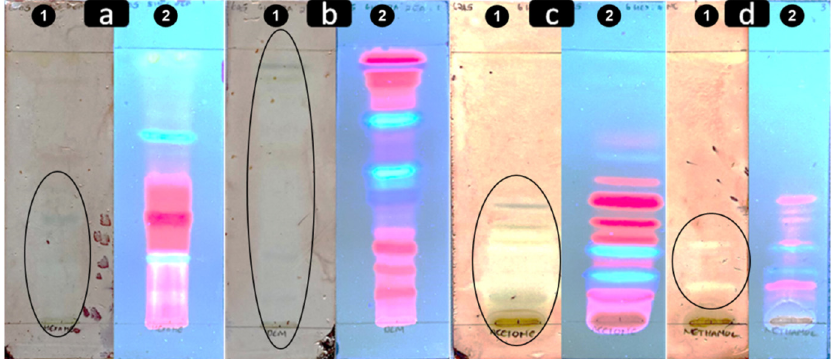
Figure 2. Developed TLC–bioautograph of M. angustifolia extracts representing compounds that have antimicrobial activity against A. baumannii . ( a1 ) Combined TLC and bioautography screening method for hexane extract; ( a2 ) developed hexane extract TLC plate visualized under UV; ( b1 ) combined TLC and bioautography screening method for DCM extract; ( b2 ) developed DCM extract TLC plate visualized under UV; ( c1 ) combined TLC and bioautography screening method for acetone extract; ( c2 ) developed acetone extract TLC plate visualized under UV; ( d1 ) combined TLC and bioautography screening method for methanol extract; ( d2 ) developed methanol extract TLC plate visualized under UV. The elliptical circles show the clear zone where bacterial growth has been